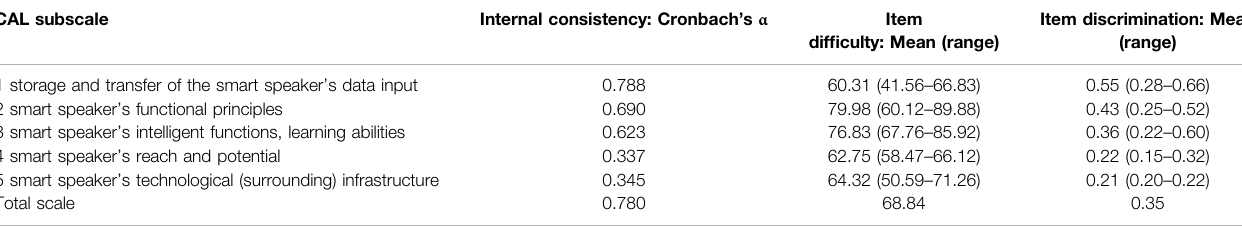
TABLE 3 | Scale and Item analysis of the CAL. CAL subscale